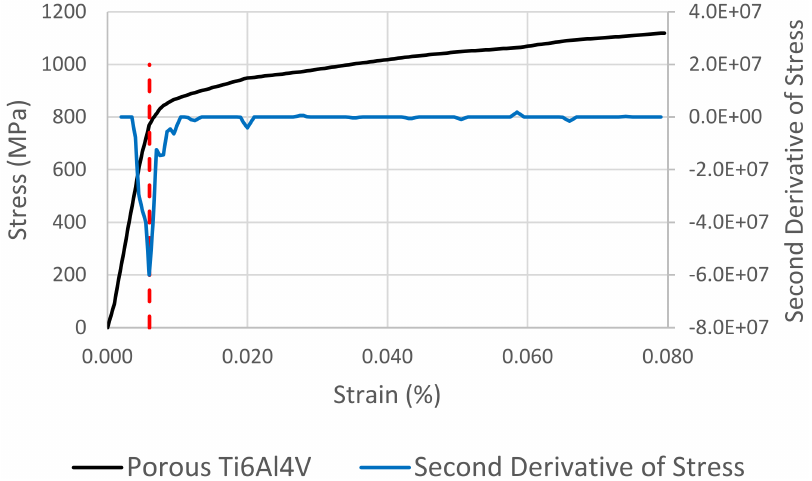
Figure 10. Derivative yield as applied to the experimentally measured stress–strain curve for porous Ti6AL4V (porosity 7.6%) subjected to tensile loading. The Strain axis to 0.5 enables the best